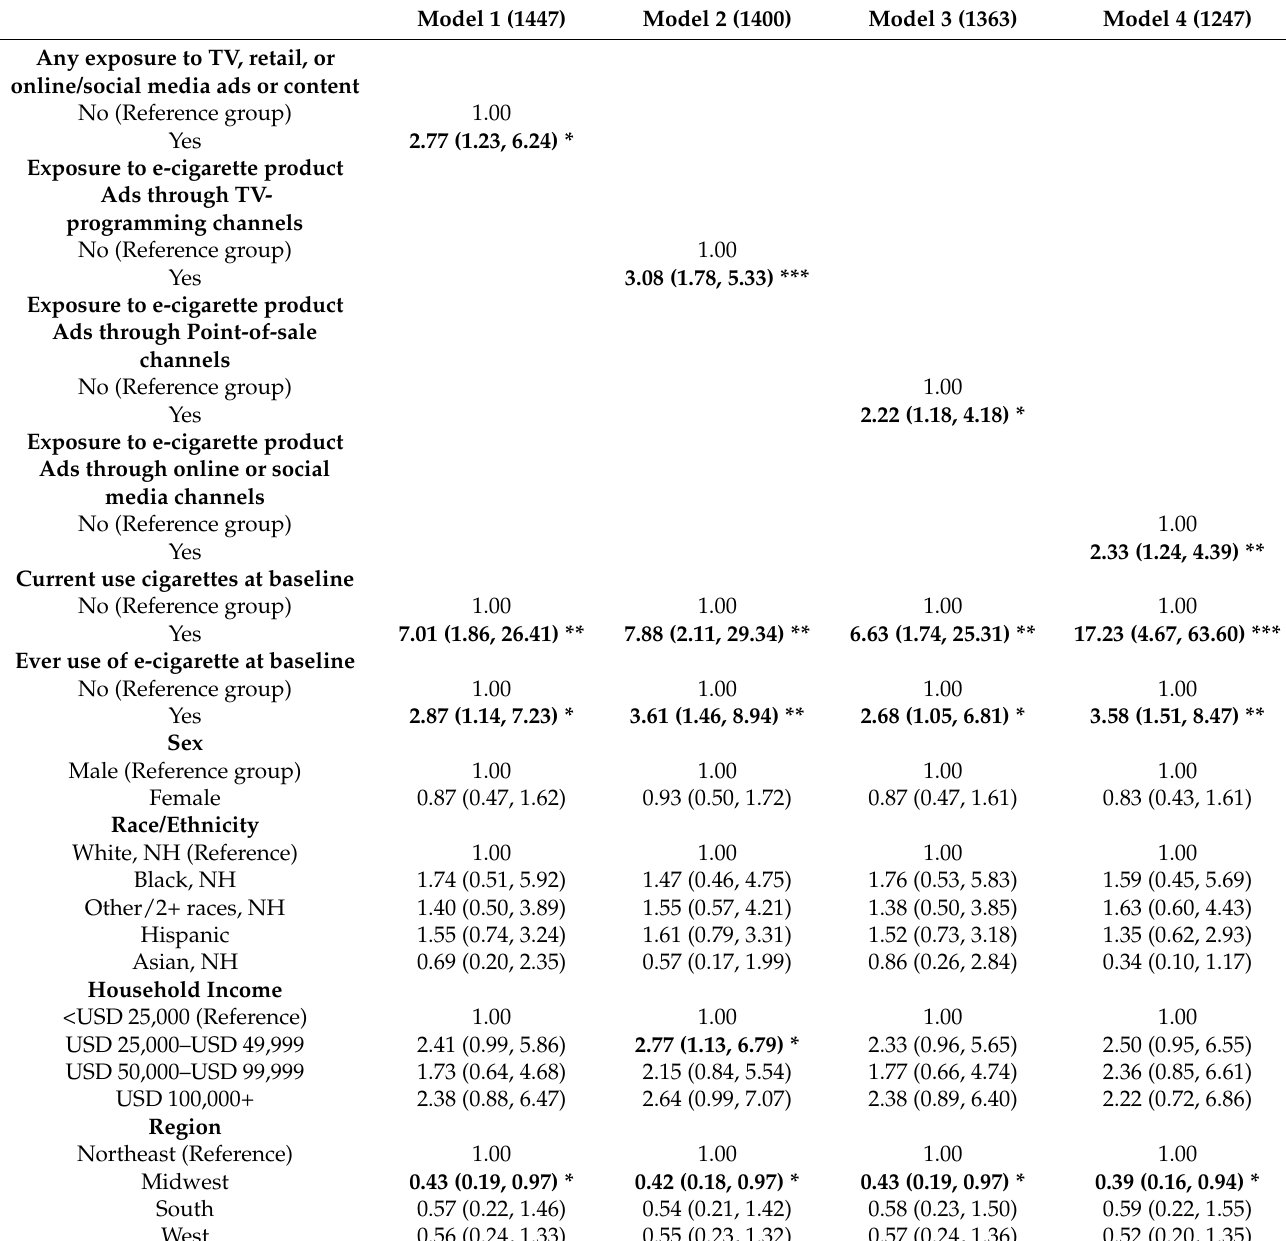
Table 3. Effect of e-cigarette advertising exposure on past 30-day e-cigarette use among youth. Model 1